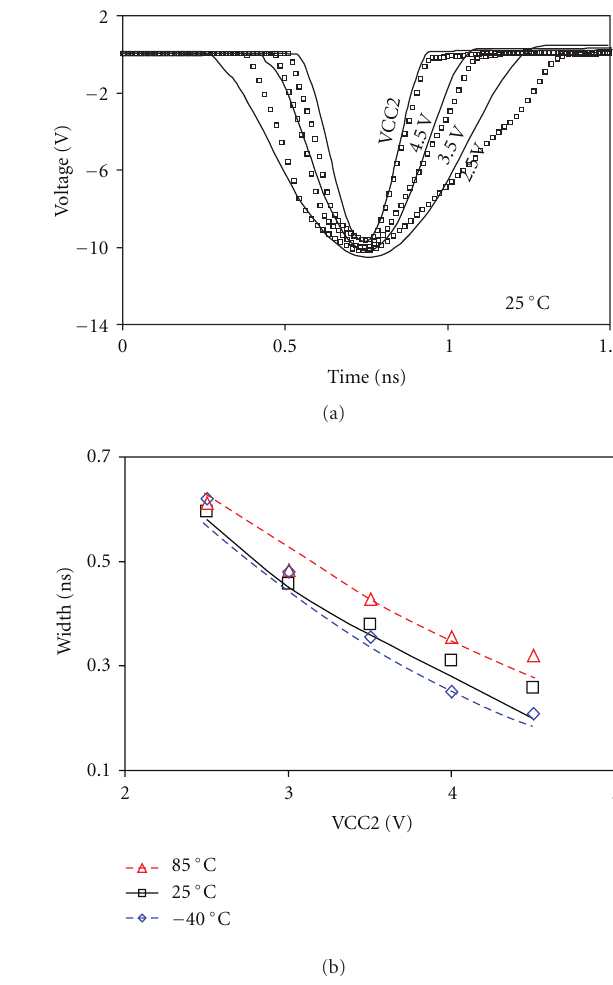
Figure 6: Measured (symbol) versus simulated (curve) (a) wave- form and (b) pulse amplitude at Node C of the pulse generator with VCC1 = VCC2 = 3.3 V, and VCC3 = 4–14 V.